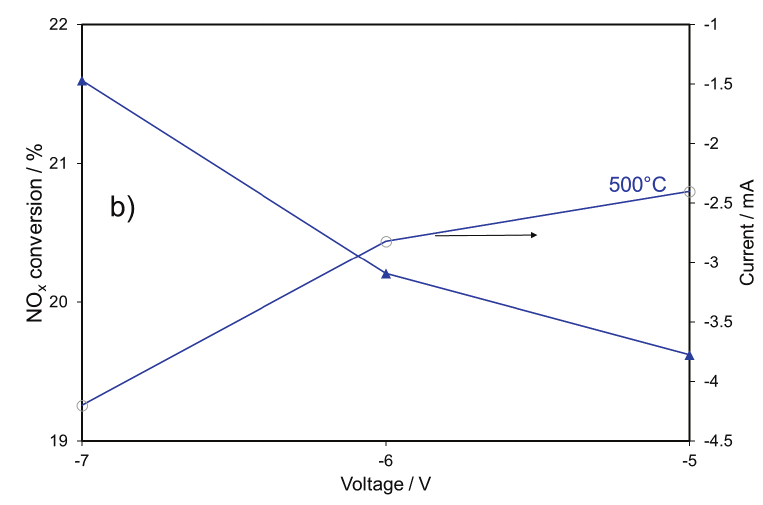
Figure 4. Variations of NO x conversion and currents as a function of applied potentials ( a ) at 450 °C and ( b ) at 500 °C. Reactive mixture: NO/NO 2 : 680 ppm/10 ppm in He.